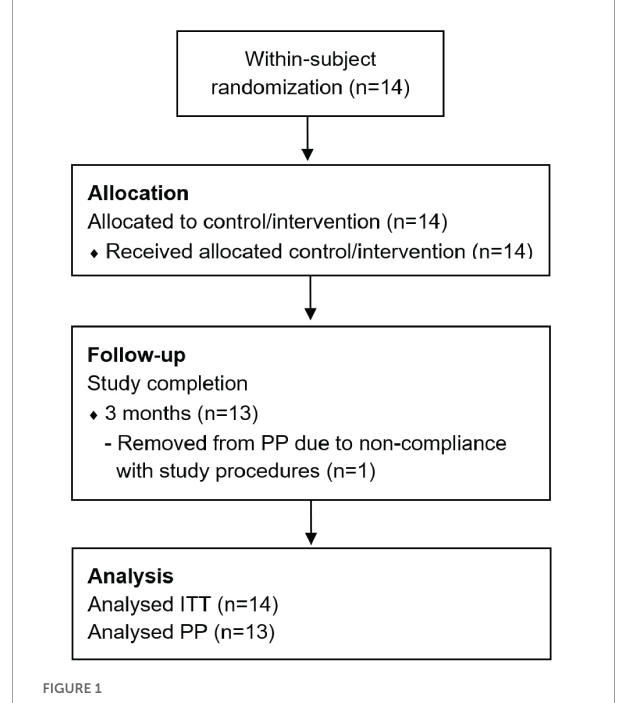
FIGURE1 Allocation, follow-up and analysis of subjects during the